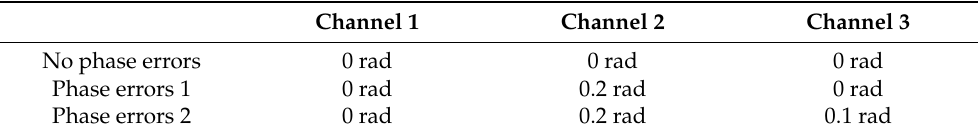
Figure 3. Effect of channel phase imbalance. ( a ) Effect of channel phase imbalance on the reconstructed filter. Solid black line: reconstruction filter response without phase error. The colored solid line shows the reconstruction filter response with 0.2 radians set for channel 2. Colored dashed lines represent the reconstruction filter response for channels 2 and 3 with 0.2 and 0.1 radians, respectively. ( b ) Effect of channel phase imbalance on the reconstructed spectrum. Table 3. Phase